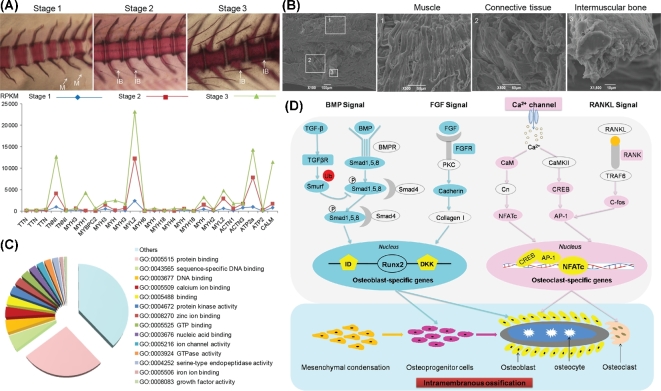
Regulation of genes related to intermuscular bone formation and function identified from developmental stages and adult tissues transcriptome data. (A) The gene expression pattern involved in muscle contraction–regulated genes in early developmental stages corresponds to the intermuscular bone formation of M. amblycephala (alizarin red staining). M: myosepta. (B) Scanning electron microscope photos of muscle tissues, connective tissues, and intermuscular bone. (C) Distribution of intermuscular bone–specific genes in GO annotations indicative of abundance in protein binding, calcium ion binding, and GTP binding functions. (D) Several developmental signals regulating key steps of osteoblast and osteoclast differentiation in the process of intramembranous ossification. Colored boxes indicate that significantly up-regulated genes in these signals specifically occurred in intermuscular bone.